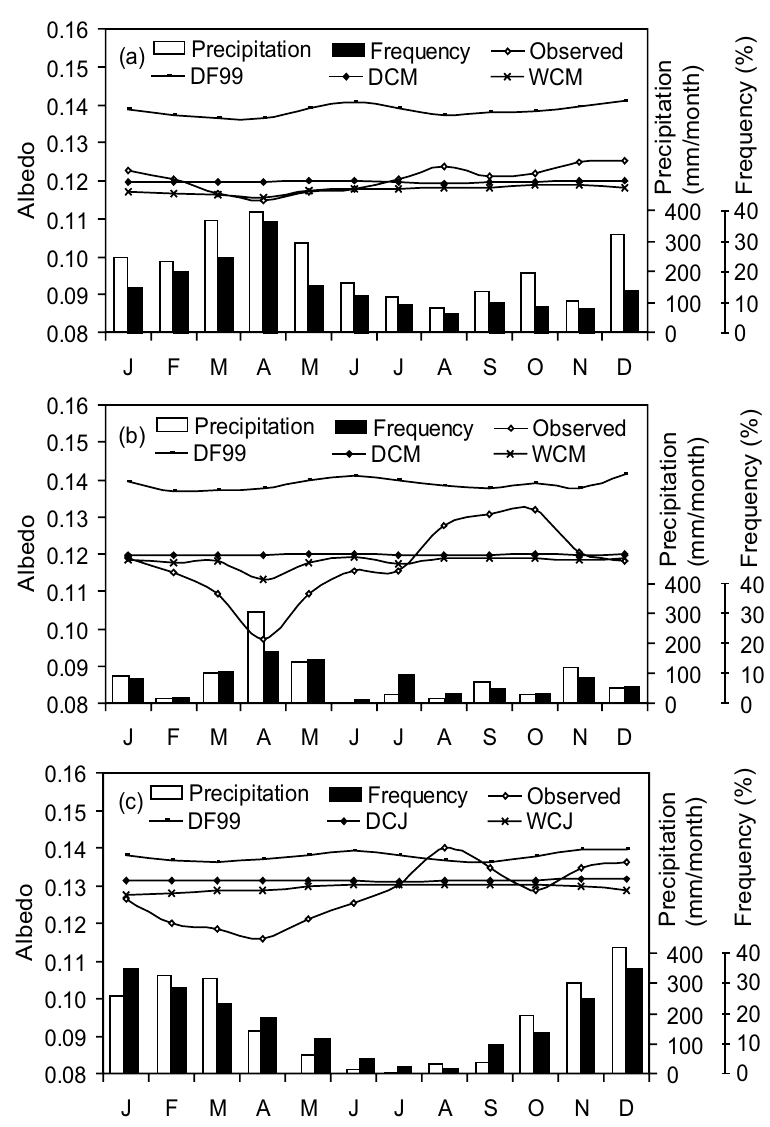
Fig. 5 – Monthly profile of the observed and simulated surface albedos, and monthly precipitation and frequency of rainfall events at three sites in the Amazon rainforest: (a) Cuieiras Reserve, from June 1999 to September 2000, (b) Ducke Reserve, from January to December 1995, and (c) Jaru Reserve, from January to December